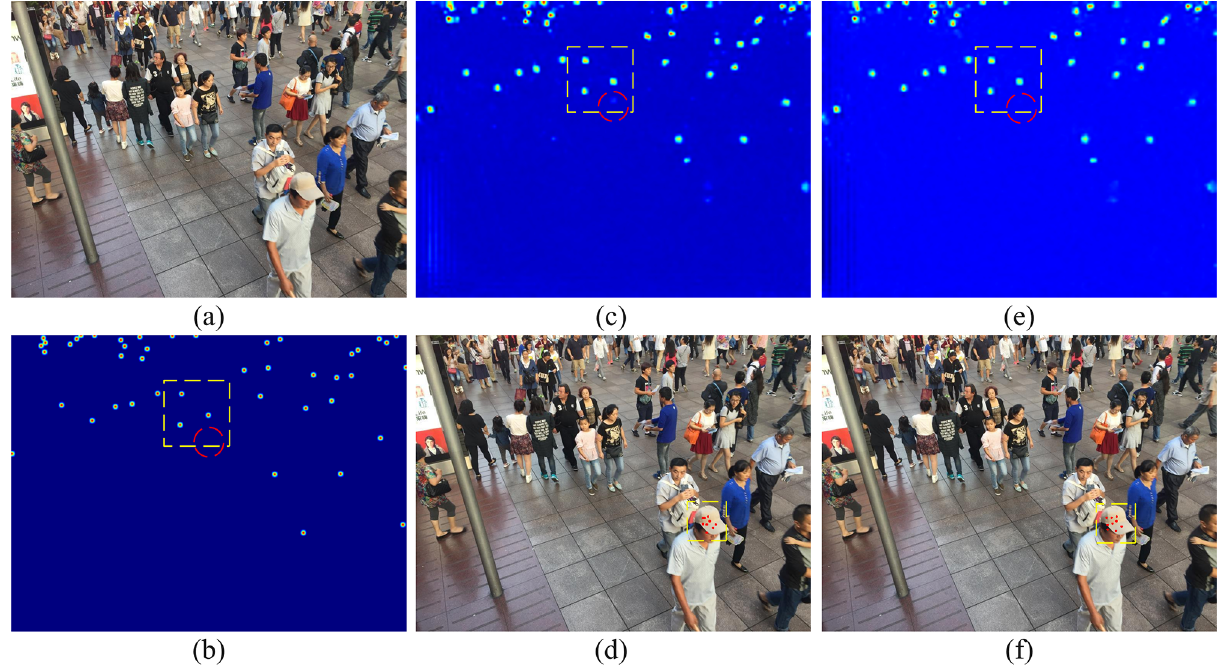
Figure 6. Visualization of an image from the ShanghaiTech B dataset. The first column shows one of the samples and its ground truth devoted as ( a ) and ( b ), respectively. The predicted density map in DConv and ODConv is shown in ( c ) and ( e ), and the visualization of offsets of DConv and ODConv is presented in ( d ) and ( f